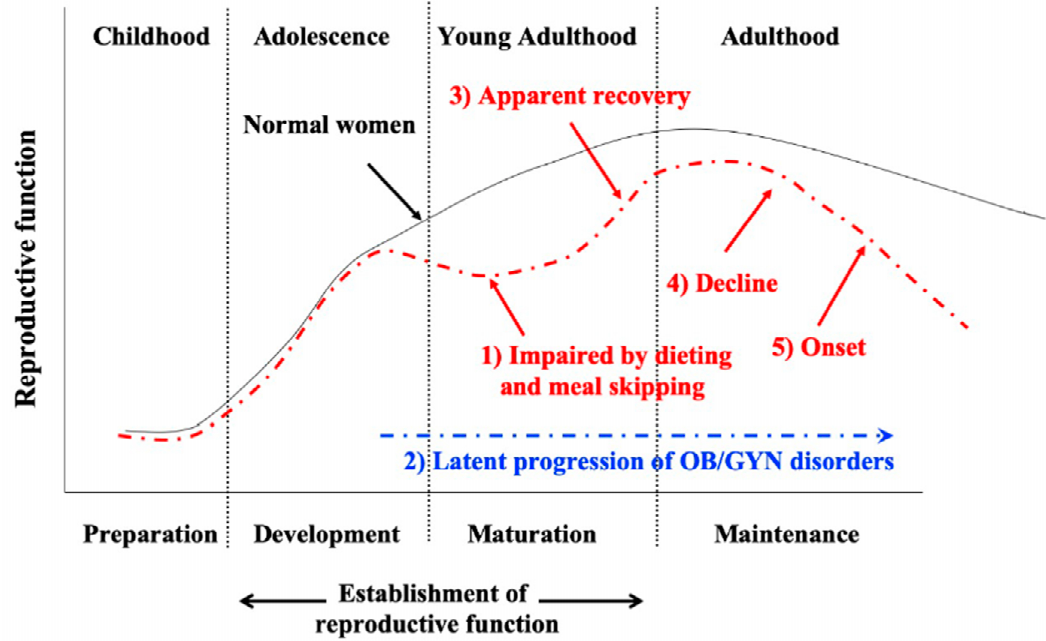
Figure 1. Concept of adolescent dietary habit-induced obstetric and gynecologic disease (ADHOGD). Adverse dietary habits, such as dieting and breakfast skipping during adolescence and adulthood, impair development and maturation of the reproductive function (1), which induces the latent progression of obstetric and gynecologic disorders (2). Although apparent recovery is achieved after correcting adverse eating habits (3), the reproductive function is precociously declined (4), which later leads to the onset of obstetrics and gynecologic diseases (5).